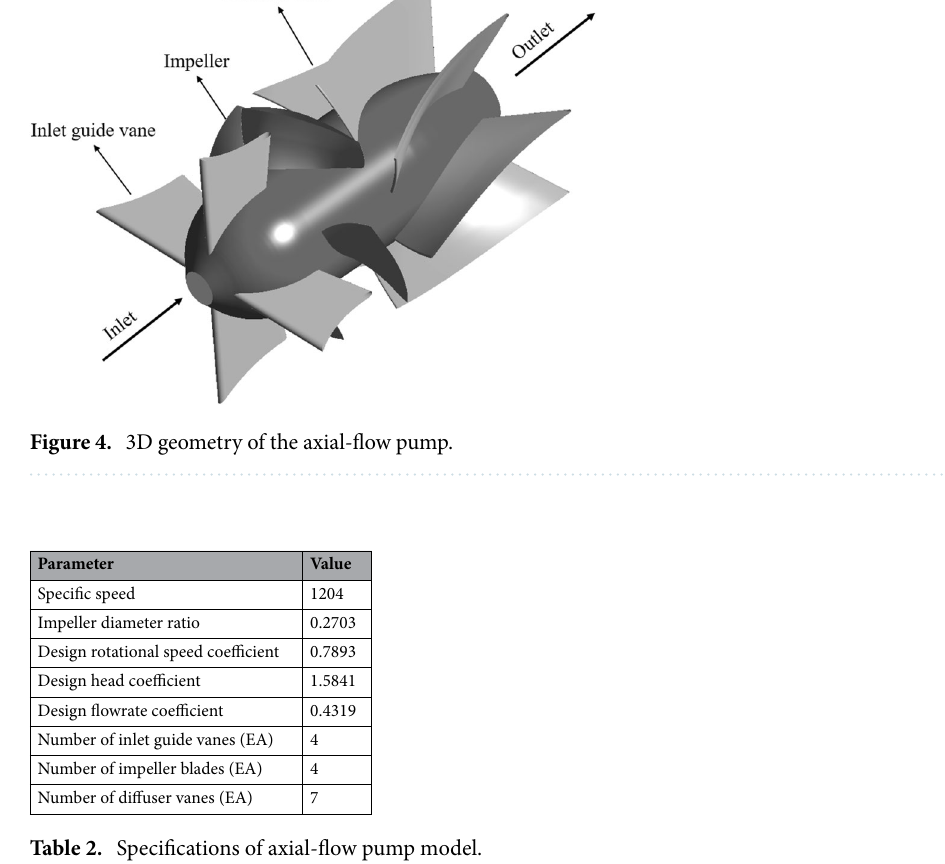
Table 2. Specifications of axial-flow pump